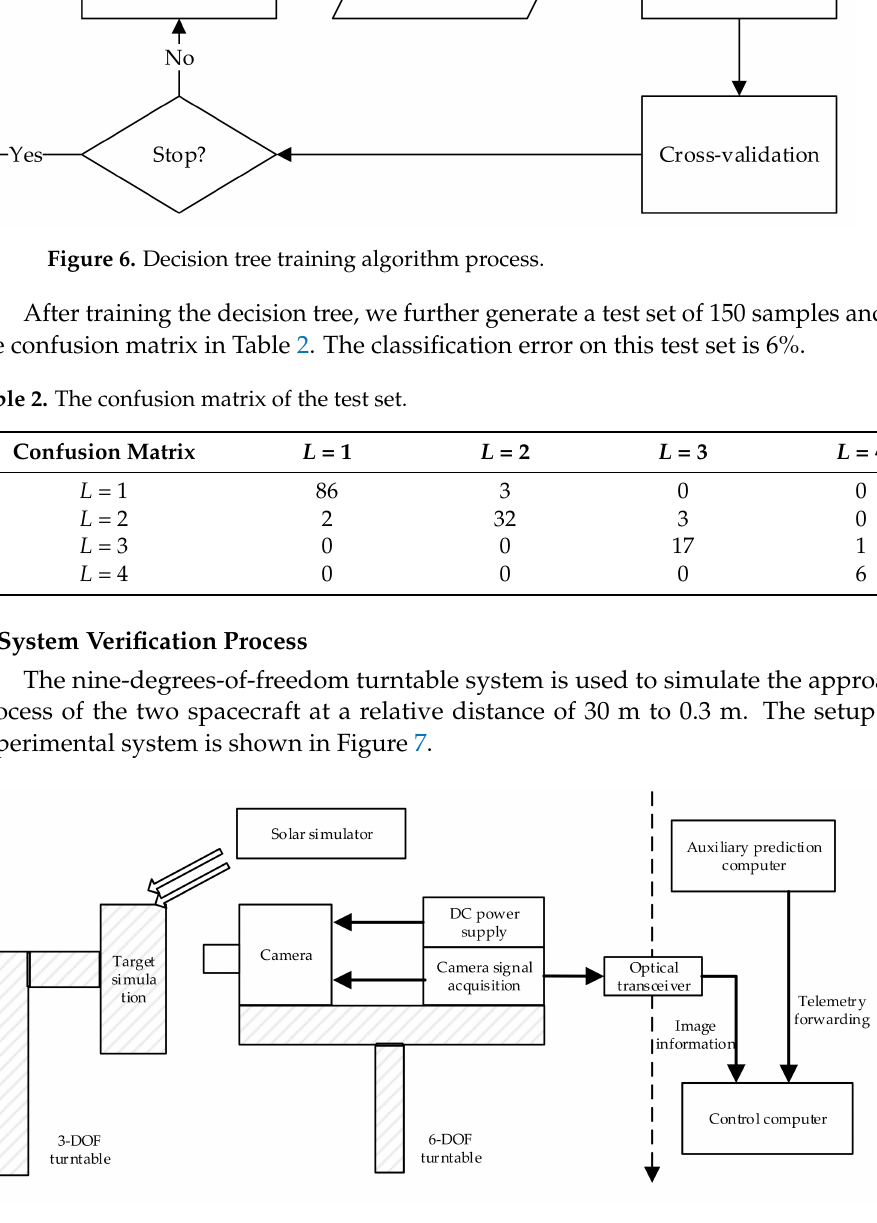
Figure 7. Diagram of a semi-physical experiment